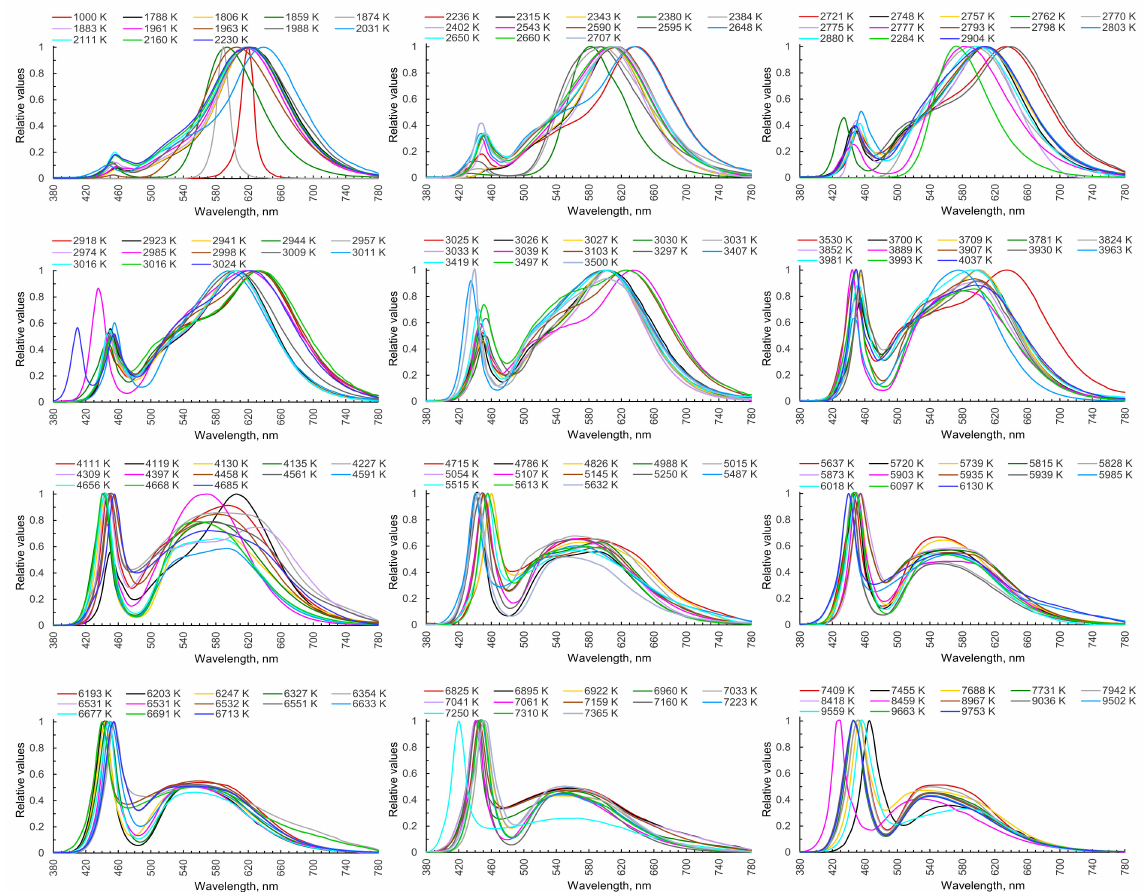
Figure 4. Relative spectra characteristics of LED sources with different closest color